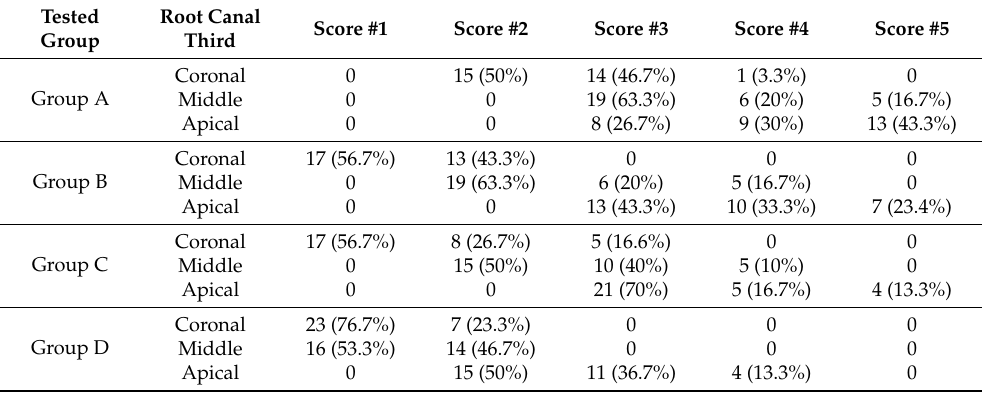
Table 1. Numerical value and percentage scores (%) of smear layer in agreement with Hülsmann et al. criteria per group.